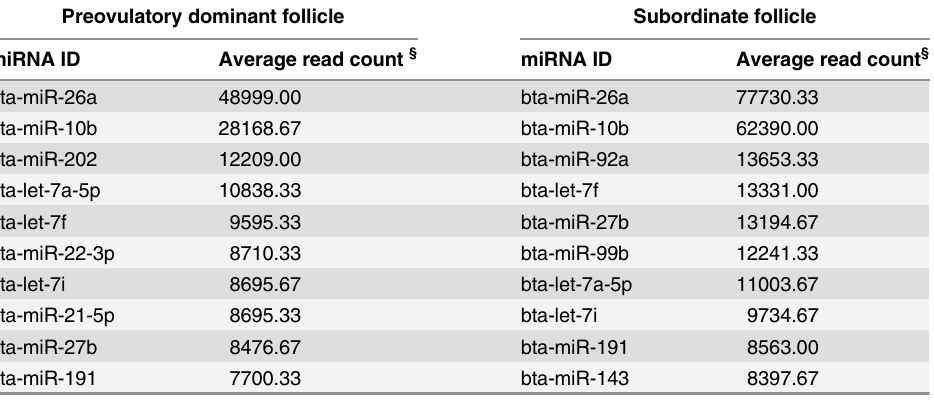
Table 2. List of Top 10 highly abundantly expressed miRNAs in granulosa cells of preovulatory domi- nant and subordinate follicles. Preovulatory dominant